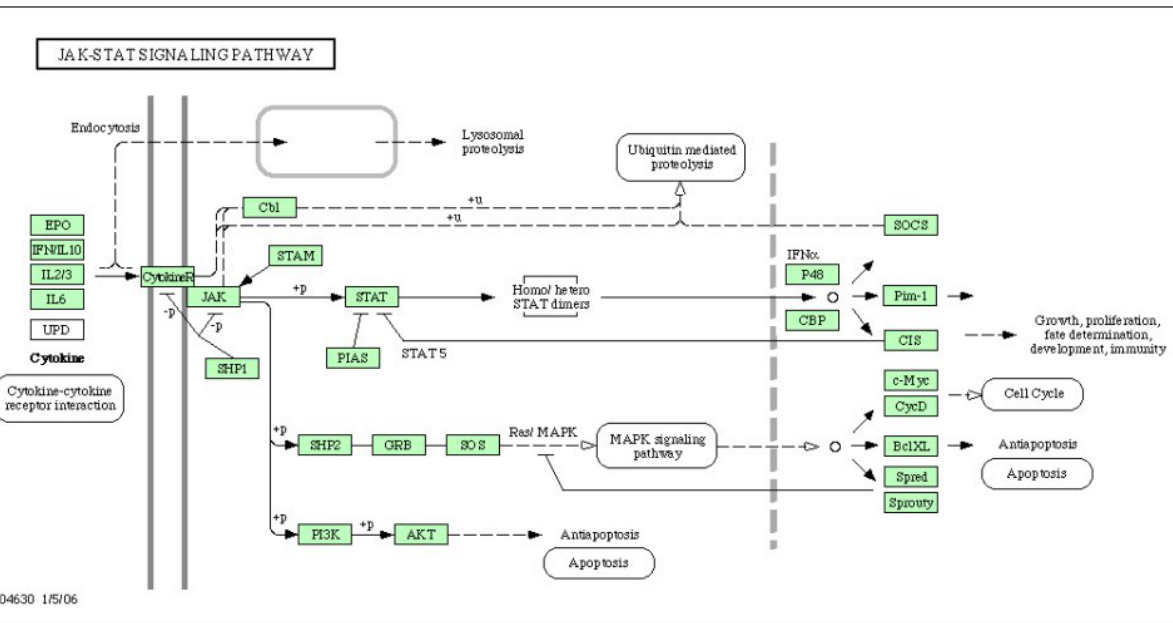
Figure 4. Cytokines-related activation of intracellular processes in glioma cells. Glioma specimens were hybridized in a GeneChip microarrays panel of the whole human genome containing approximately 44000 genes. The scheme presented results from statistical analysis as displayed by Gene Spring GX 7.3 software (personal, unpublished